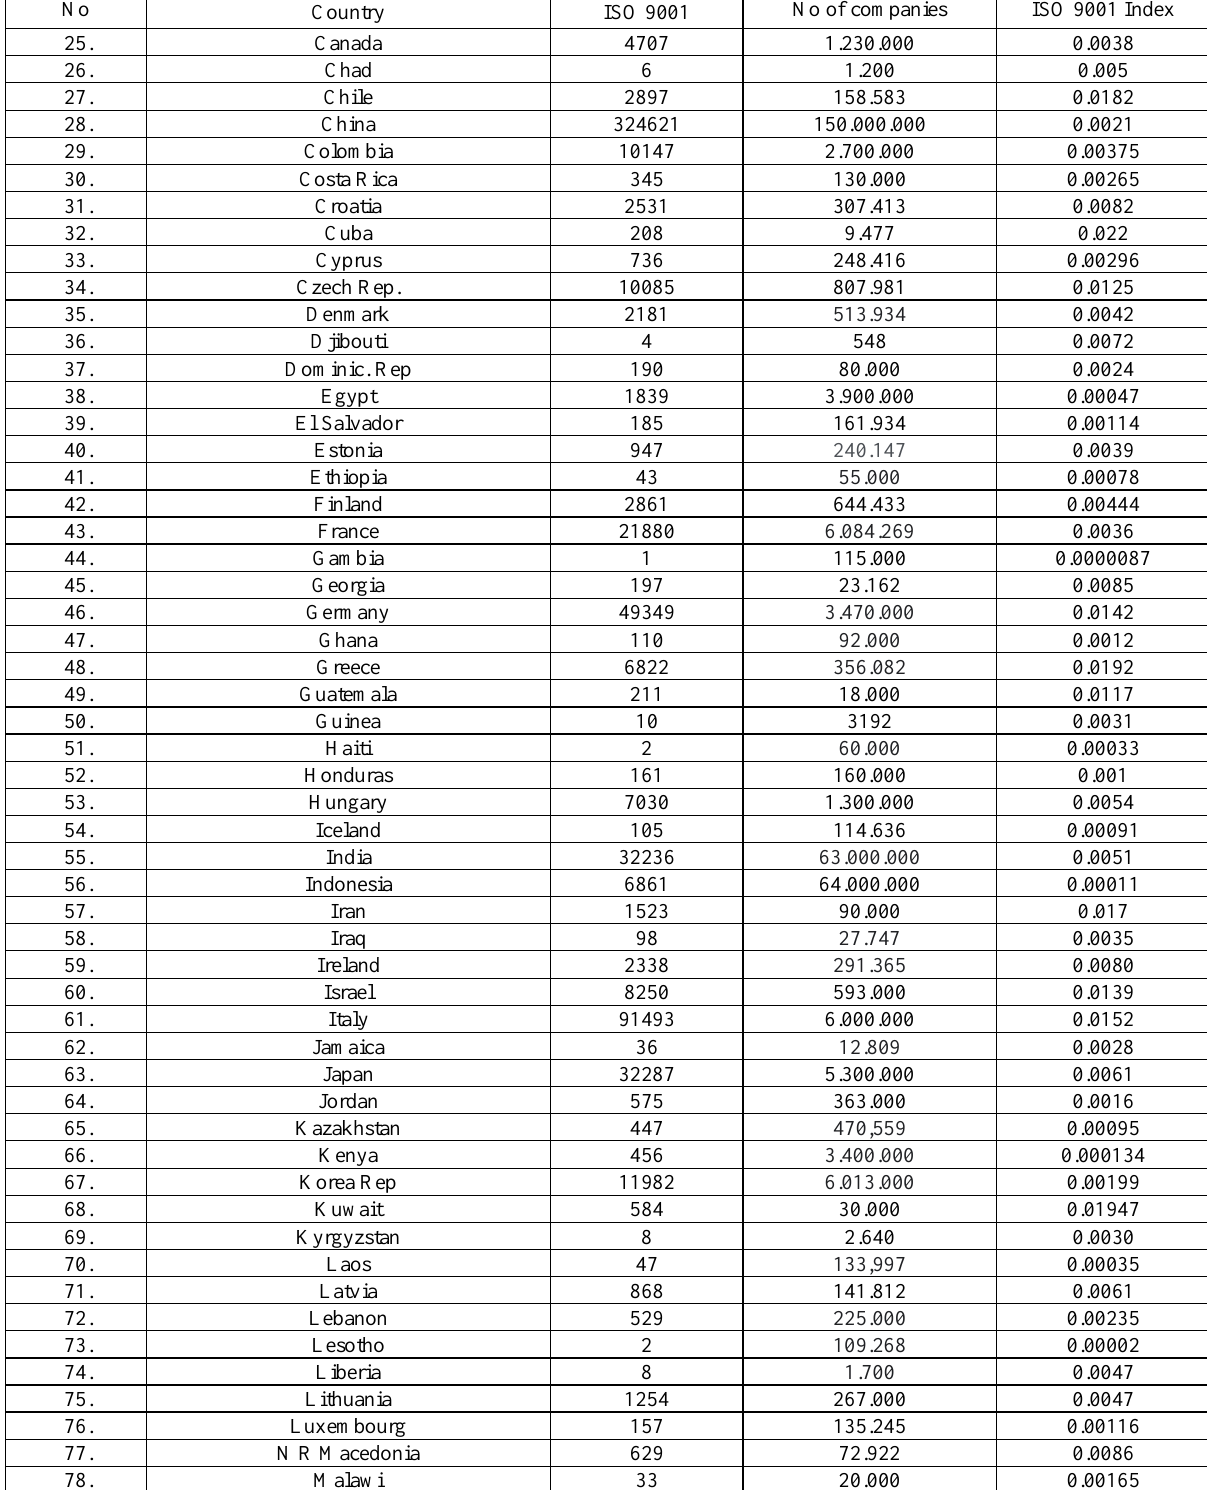
Table 1 (cont.). List of countries for ISO 9001 certificates issued in alphabetic order (taken from ISO), number of businesses per country (taken from HitHorizon), and ISO 9001 index per country (136 countries